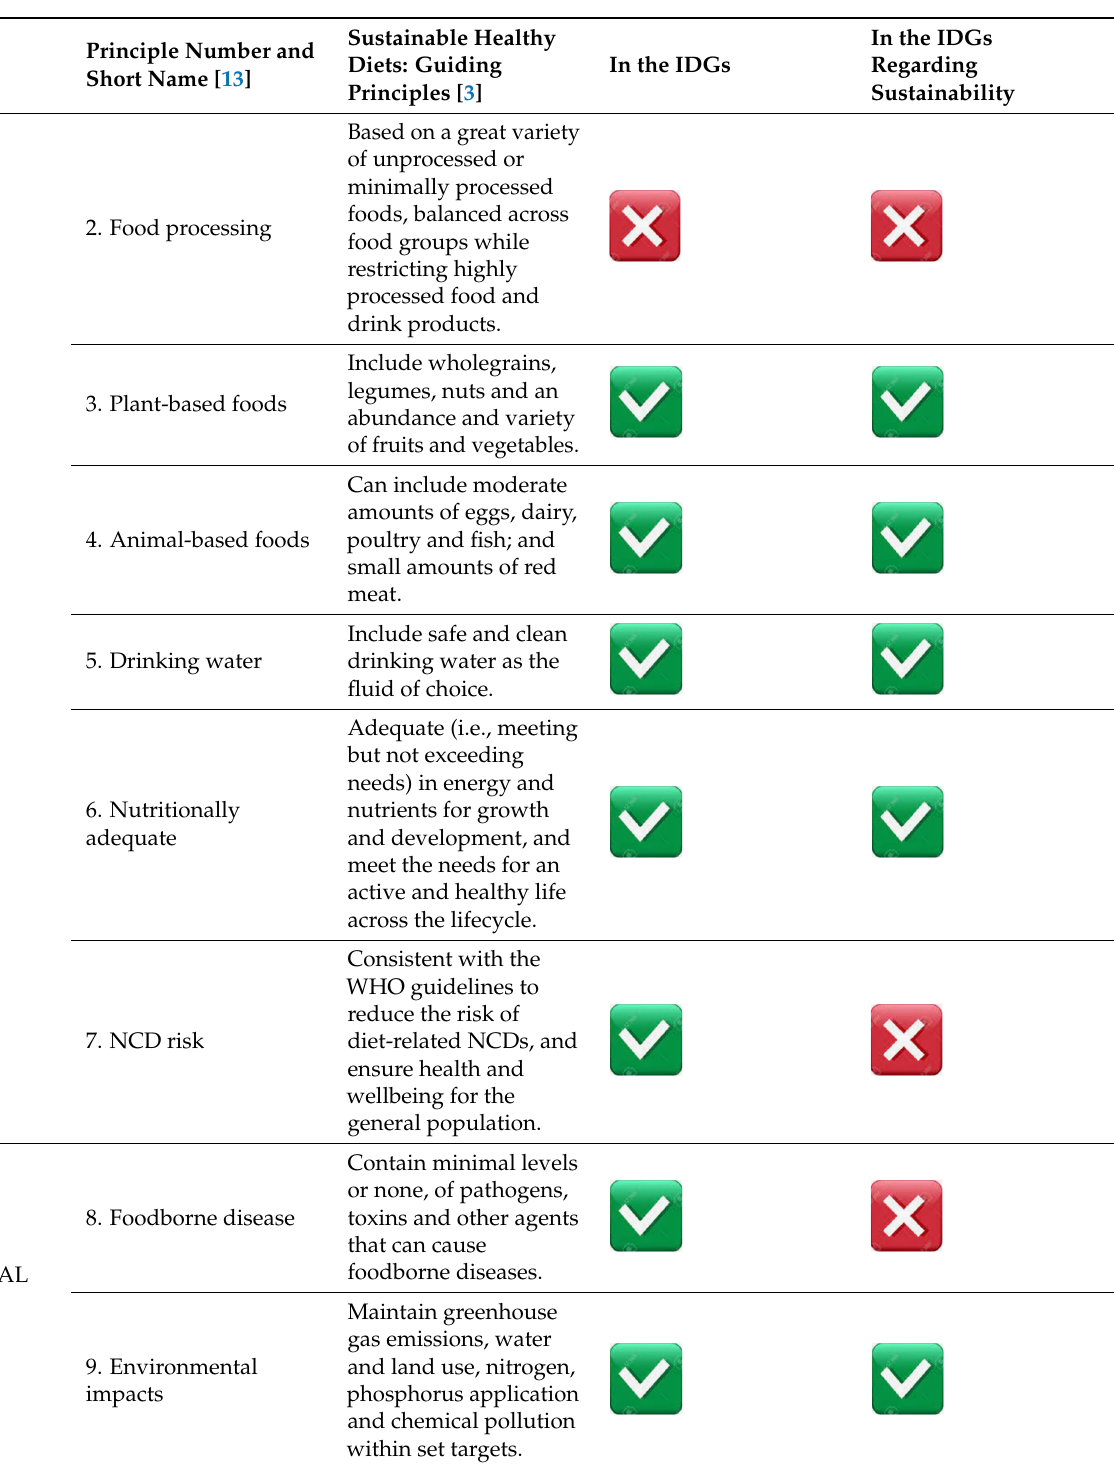
Table 1. The 16 guiding principles of a sustainable healthy diet in the IDGs regarding sustainability. Key to symbols: included; not included. Table 1. Cont.